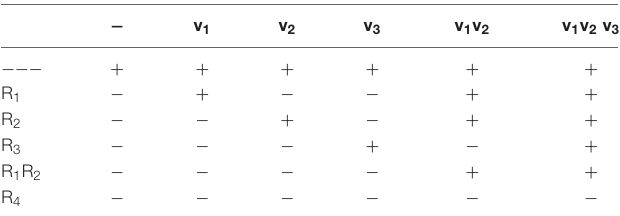
TABLE 1 | Patterns of host–pathogen responses in the three models. In all three cases “ + ” indicates the occurrence of a compatible reaction (susceptibility) while “ − ” indicates an incompatible reaction (resistance). (A) Pattern associated with gene-for-gene interactions where R refers to host resistance loci and v is the recessive (infective) form of pathogen infectivity loci (i.e., V would be the non-infective form). Thus, v 1 represents a pathotype able to infect completely susceptible hosts ( −−− ) or those with R 1 only, but is ineffective against others assuming this pathotype also carries V 2 , V 3 , and V 4